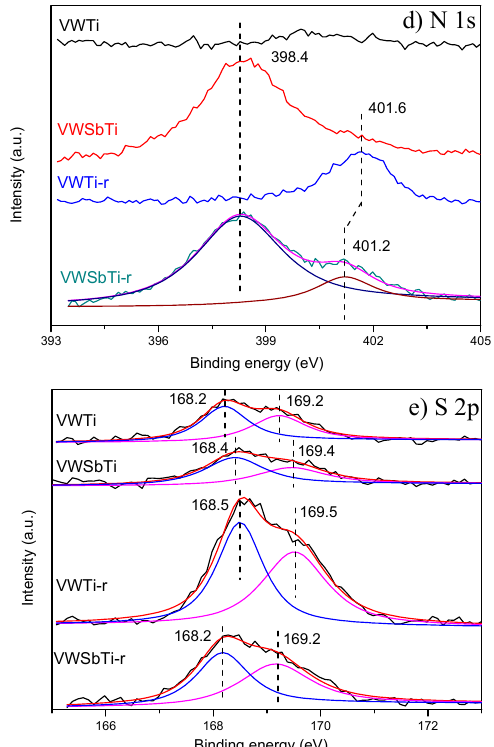
Figure 5. XPS spectra of various catalysts. ( a ) Ti 2p spectra; ( b ) V 2p spectra; ( c ) O 1s spectra; ( d ) N 1s spectra; ( e ) S 2p spectra.